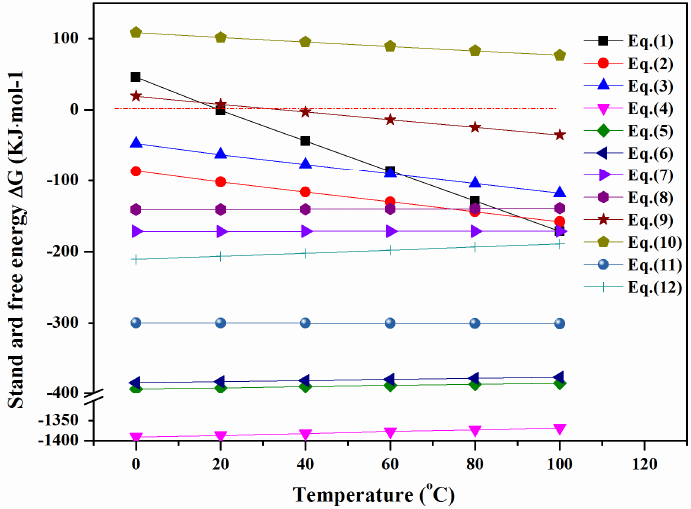
Figure 10. Standard free energy changes vs. temperature for Equations (1)–(12). The thermodynamic data was obtained from HSC Software Version 6.0 (Outokumpu Research Oy, Pori, Finland).